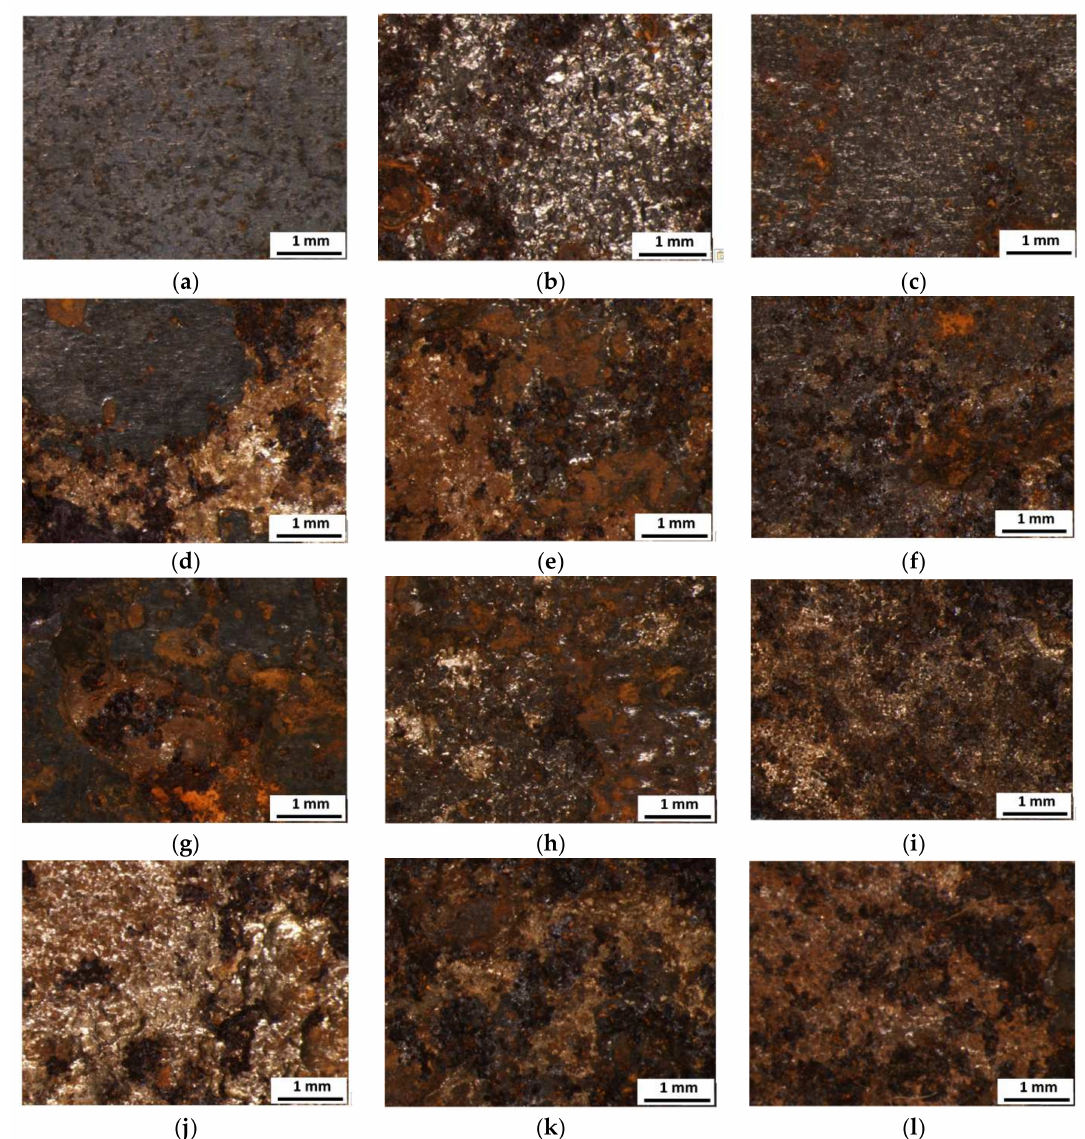
Figure 2. Images of corroded surface. ( a ) S235—1 day, ( b ) MC700—1 day, ( c ) MC1100—1 day, ( d ) S235—11 days, ( e )